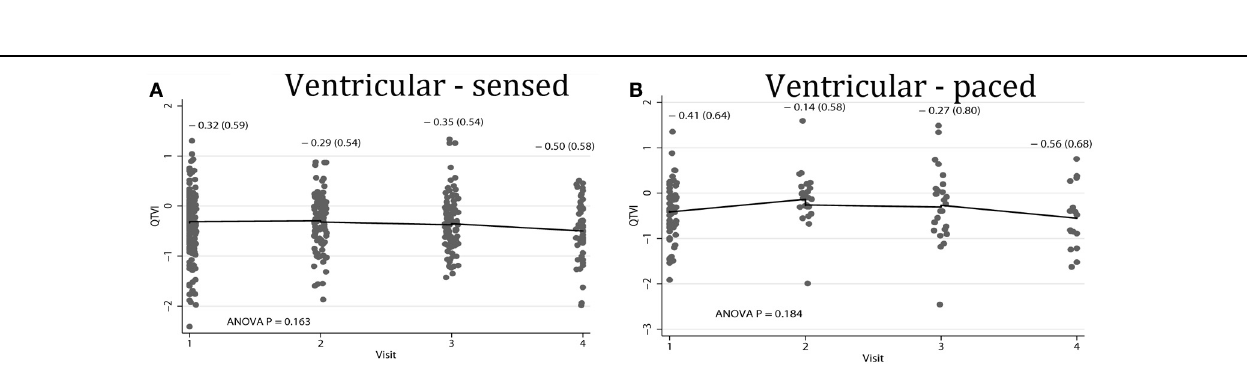
with multiple FVT/VF events. In contrast, patients with a sin- gle FVT/VF event tended to demonstrate rather decreasing over time QTVI NF . However, small subgroups size did not allow us to quantify observed